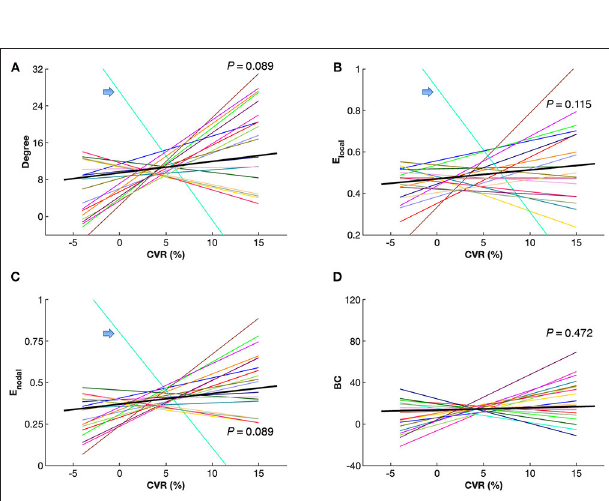
FIGURE 6 | Correlations between cerebrovascular reactivity (CVR) and network parameters, including degree (A) , local efficiency E local (B) , nodal efficiency E nodal (C) and betweenness centrality (BC) (D) in the contralateral hemispheres of the patients. Mixed-effects model showed a trend toward significant correlations between CVR and degree, as well as between CVR and E nodal ( P < 0.10, false discovery rate corrected). Each colored line represents an individual patient. The black bold lines indicate overall trends across patients. Arrows indicate a single patient (P9) with a trend deviating from the others. Connectivity sparsity was set to